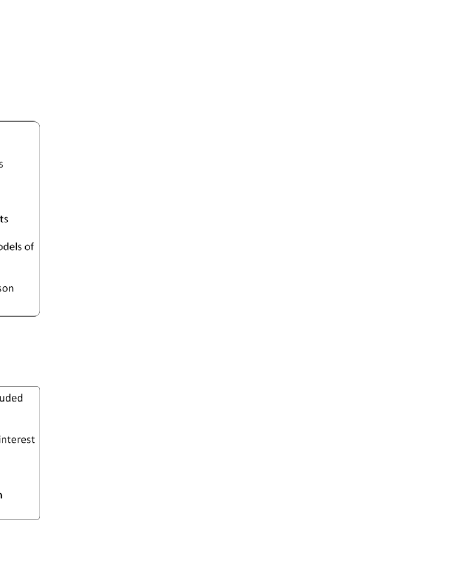
Fig 1. Flow diagram of study selection